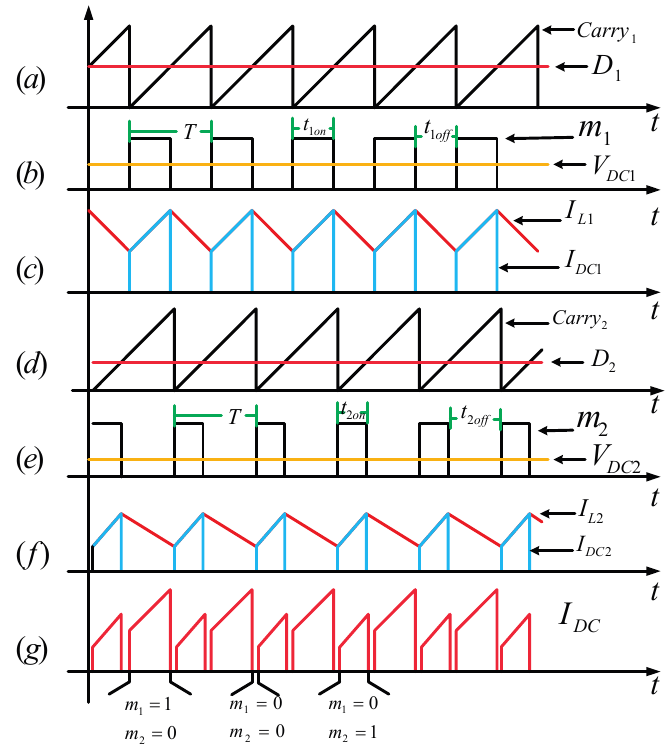
Figure 4. Main waveforms for buck 1 and buck 2 converters ( a ) carry 1 and D 1 ; ( b ) m 1